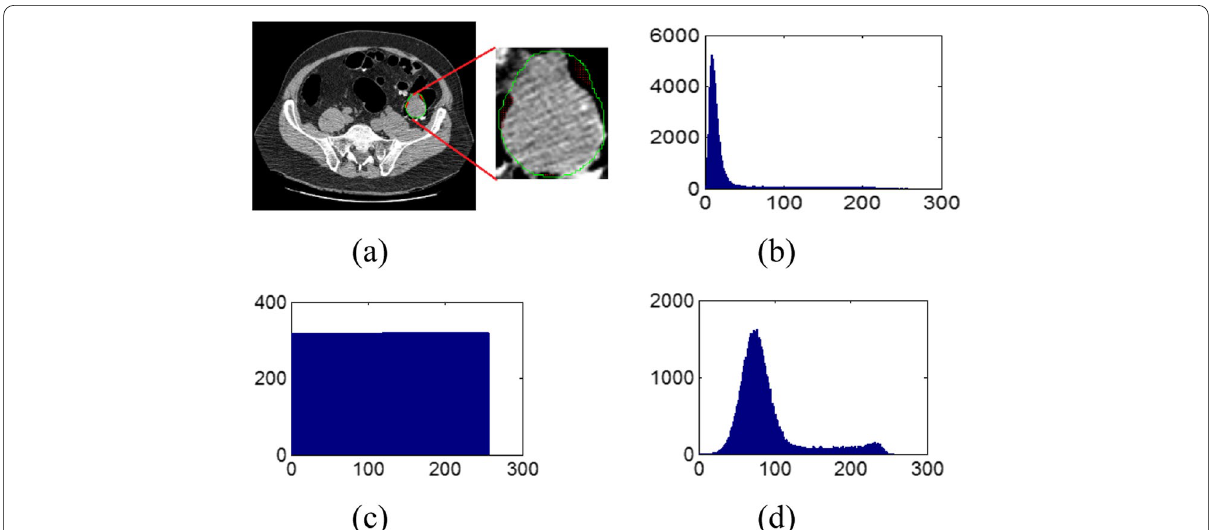
Fig. 3 Gradient magnitude histogram with 256 Gy levels. ( a ): One slice from a 3D polyp volume; ( b ): Gradient magnitude under uniform gray scaling; ( c ): Gradient magnitude under non-uniform gray scaling; ( d ): Histogram after t -th root mapping with t